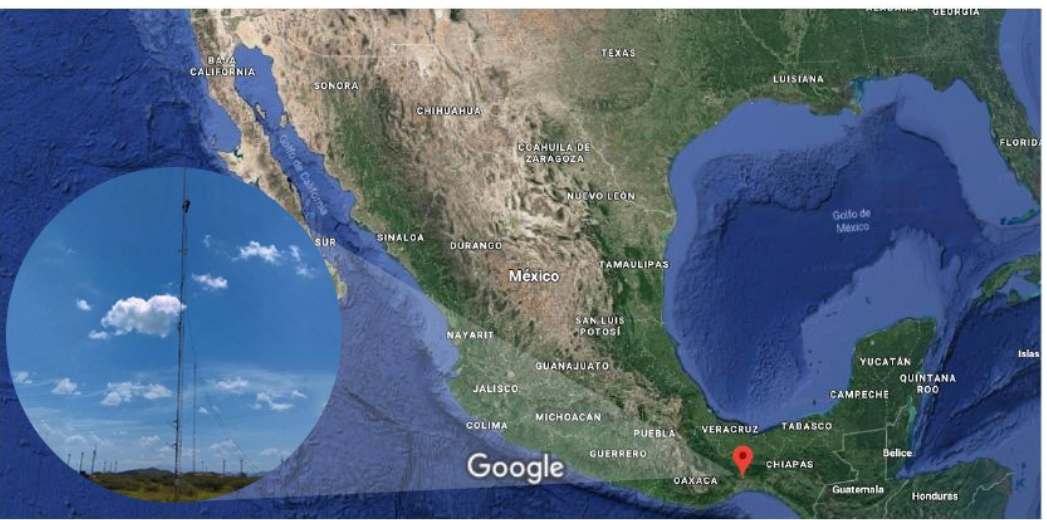
Figure 2. Photograph of the lattice met mast, 43 m in height, located at La Ventosa, Oaxaca.